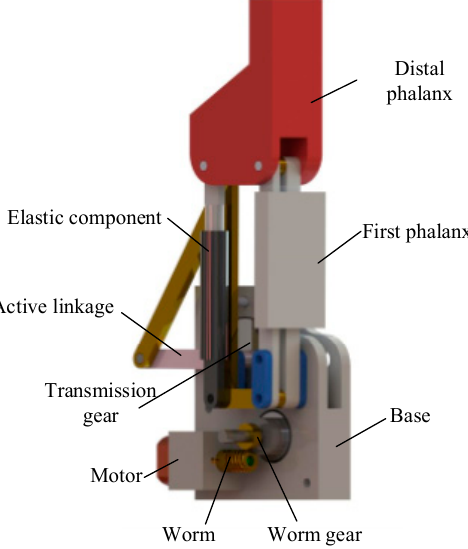
Figure 4. The architecture of the proposed VGS finger.